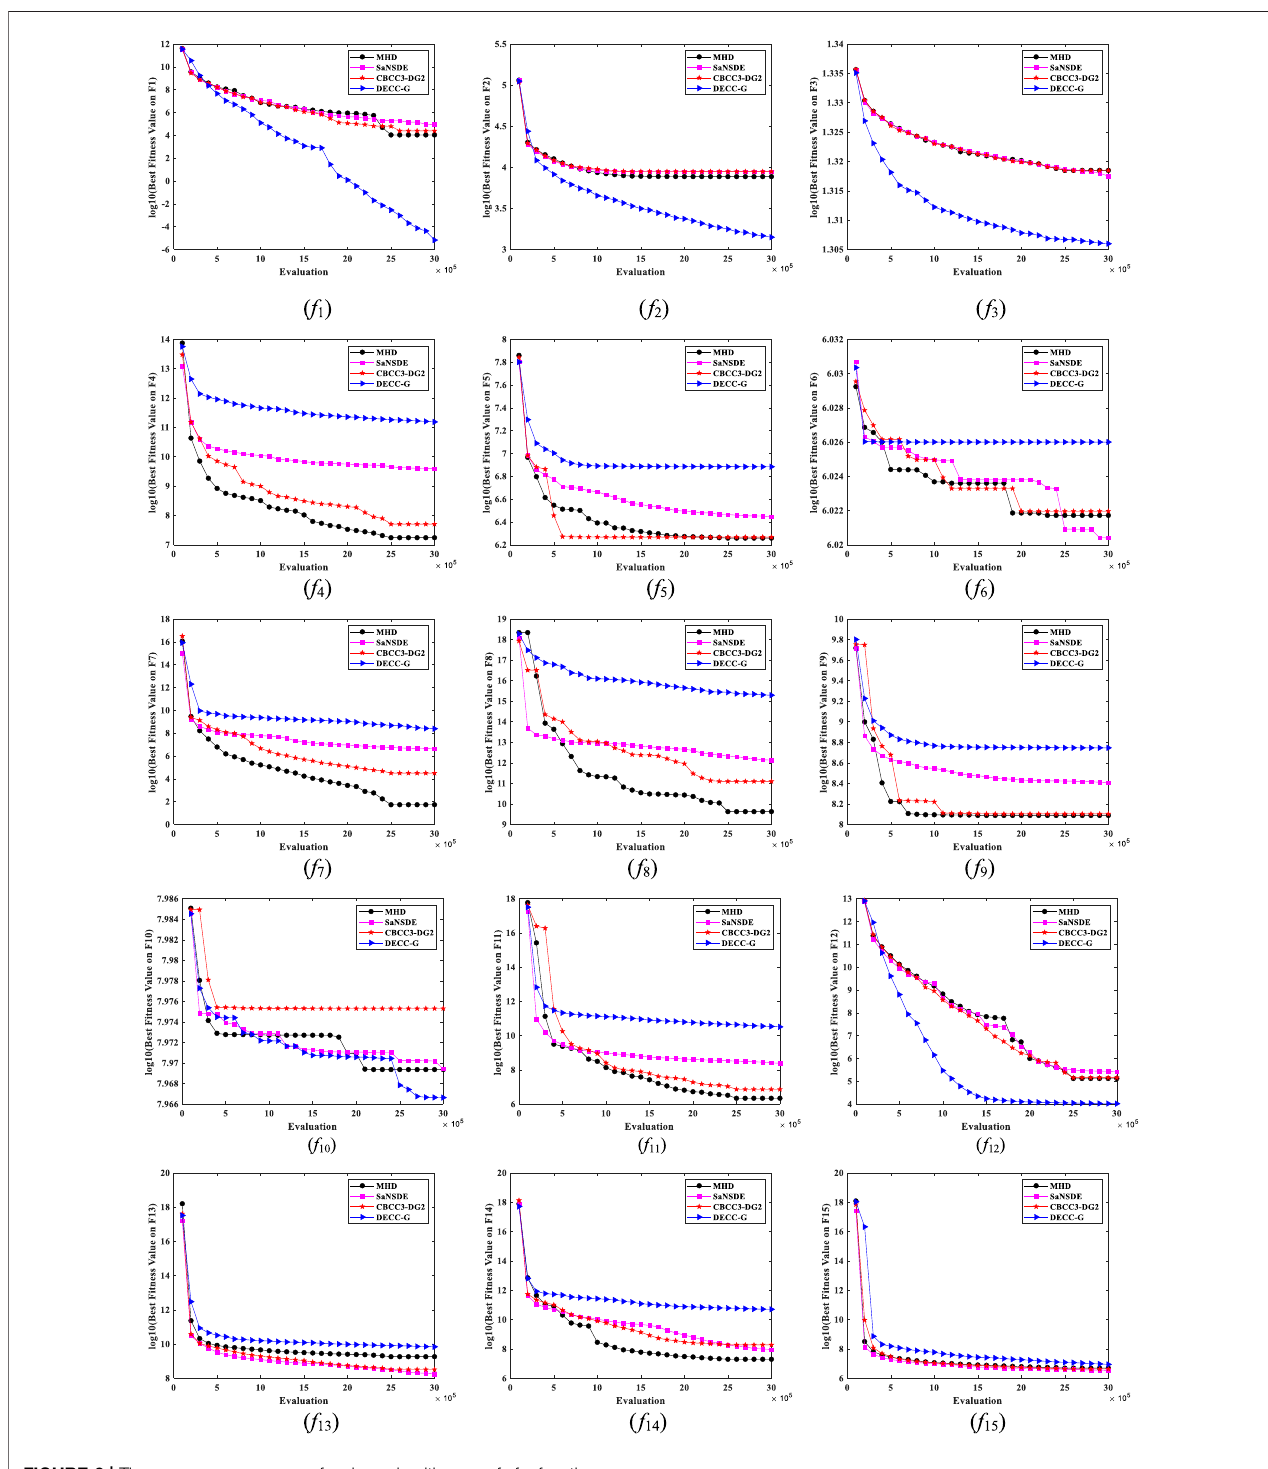
FIGURE 2 | The convergence curves of various algorithms on f 1 - f 15 functions.